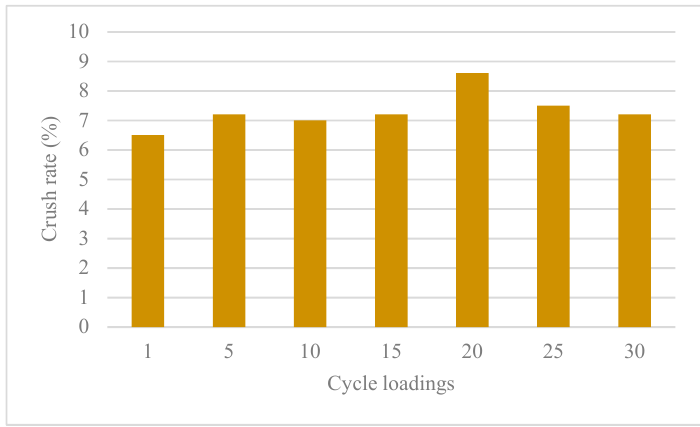
Figure 5. Crush rate at 27.68 MPa .